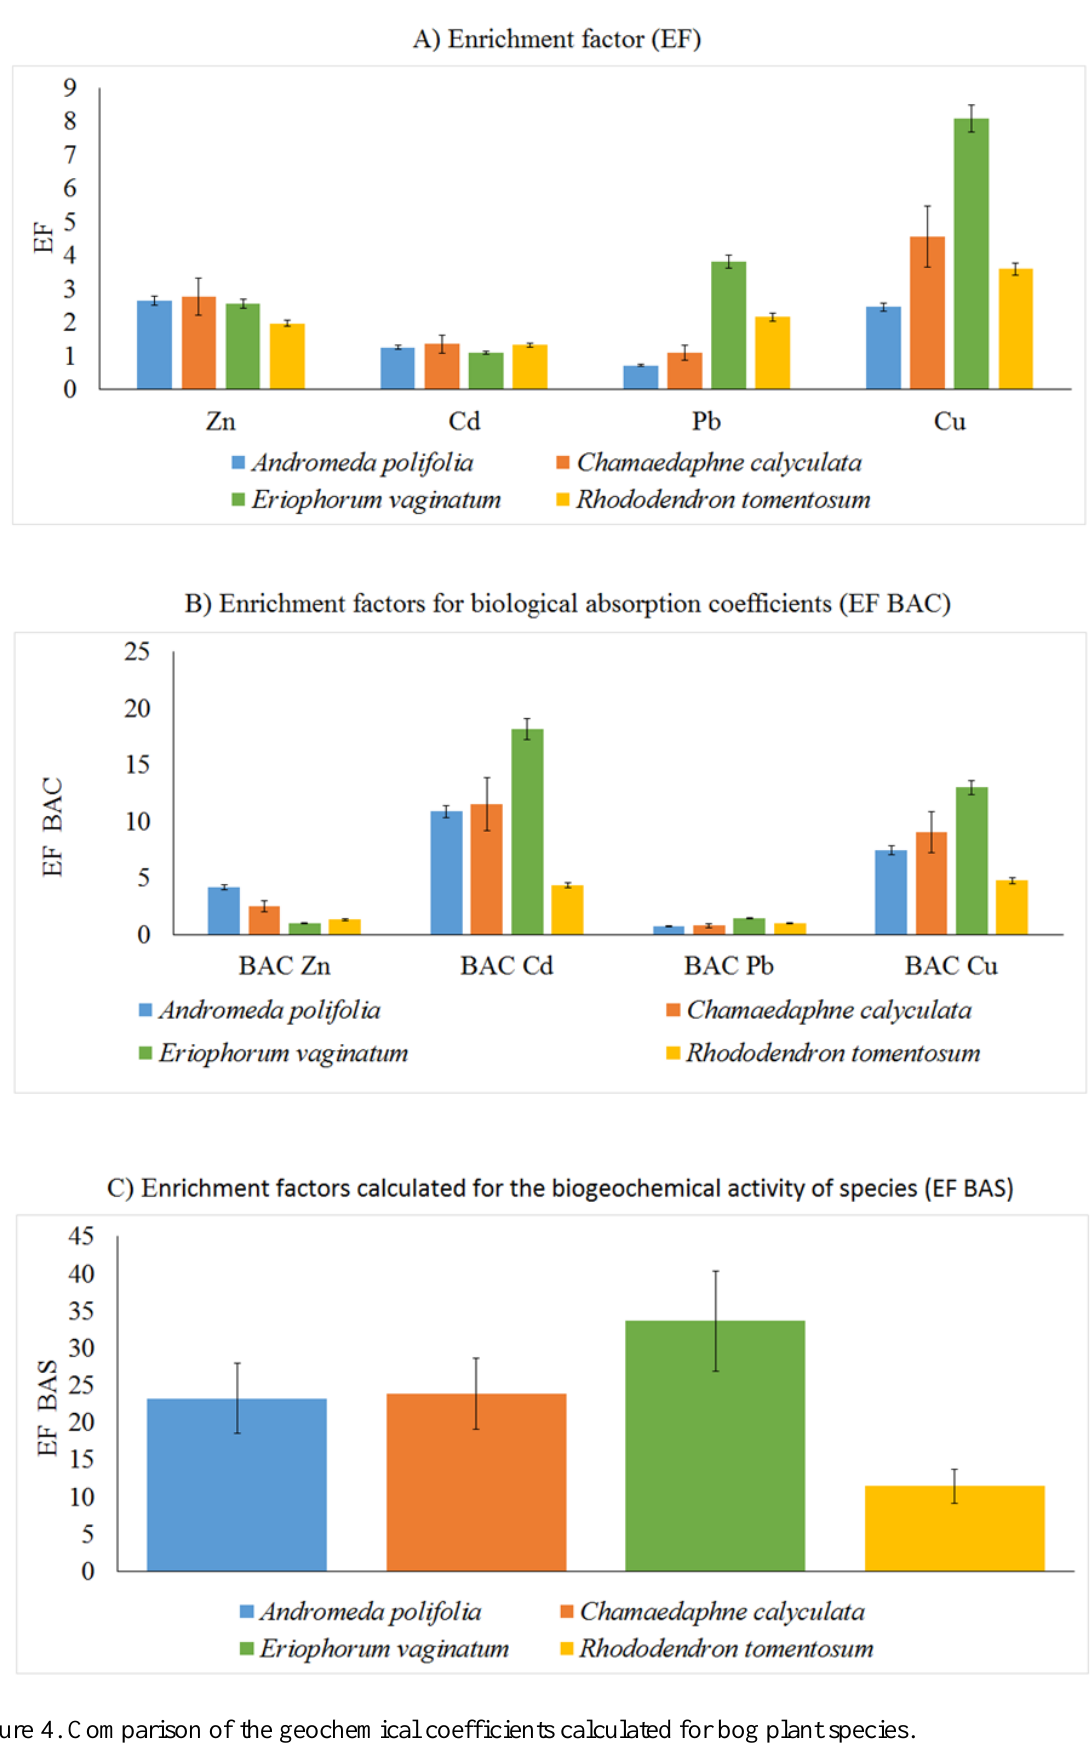
Figure 4. Comparison of the geochemical coefficients calculated for bog plant